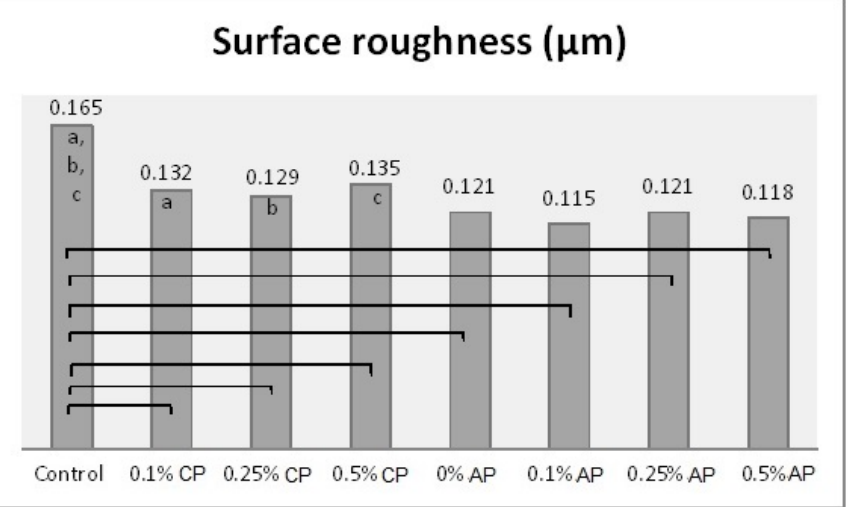
Figure 3. Mean of surface roughness ( μ m) and significances between groups for ND concentrations and polymerization techniques. Same lower-case letters show significant differences in mean within CP group. Lines show the significant differences between all groups comparing polymerization techniques .